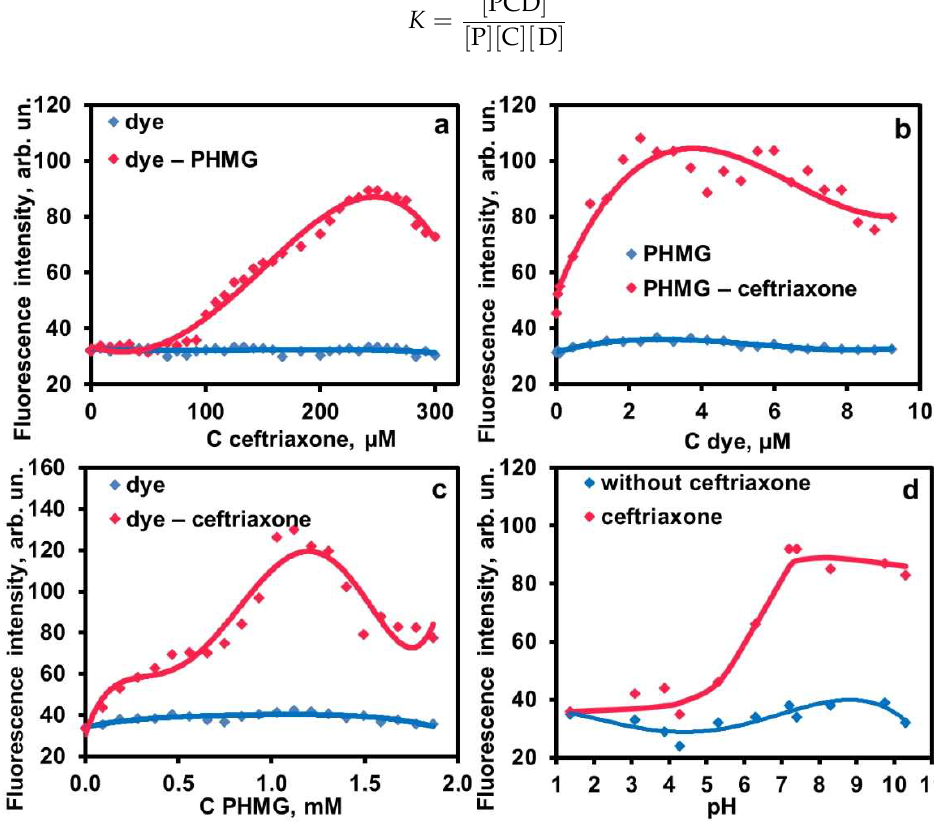
Figure 3. NIR fluorescence intensity for different concentrations of ceftriaxone ( a ), dye ( b ), PHMG ( c ) and pH ( d ). General conditions: pH 7.4 (7 mM phosphate buffer), 2.2 mM PHMG, 2.8 μM dye, 1 mM ceftriaxone. In varying pH, the following buffers were used in 7 mM concentrations (by anion): borate (pH 9–10), phosphate (pH 5.5–8.1), acetate (pH 3.5–5.0), and HCl (pH 1.8–2.8).